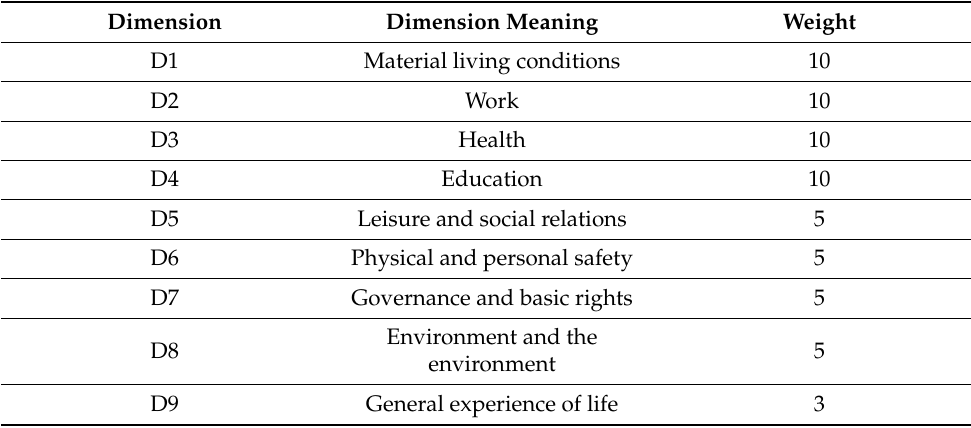
Table 12. Weight for each dimension introduced by authors in INE model. Dimension